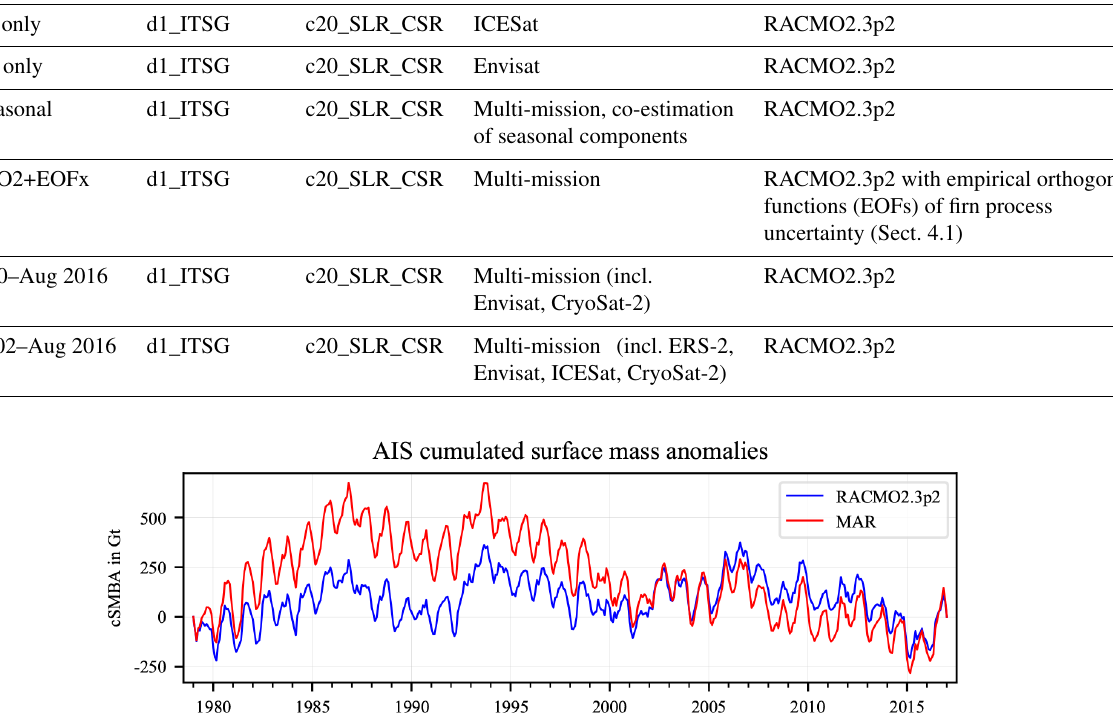
Figure 2. Cumulated surface mass balance anomalies (cSMBAs) of the regional climate models RACMO2.3p2 (blue; van Wessem et al., 2018) and MAR (red; Agosta et al., 2019), integrated over the grounded